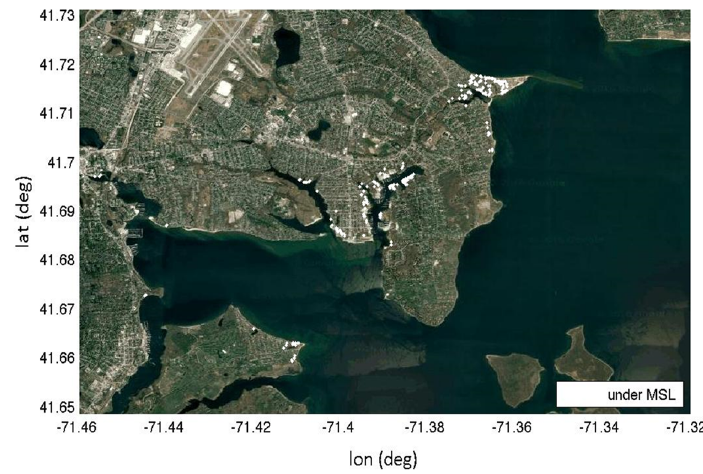
Figure A8. Structures located below MSL (white dots) with 2.1 m (7 feet) of SLR for Warwick, RI.